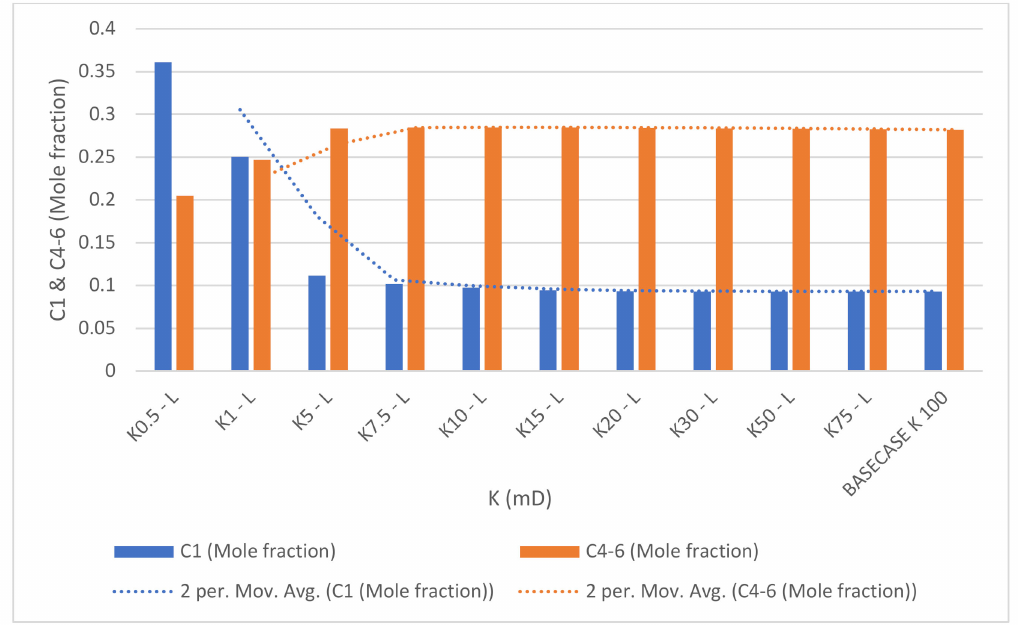
Figure 14. Comparison of the cumulative hydrocarbon composition (C 1 and C 4–6 ) at the wellbore, local